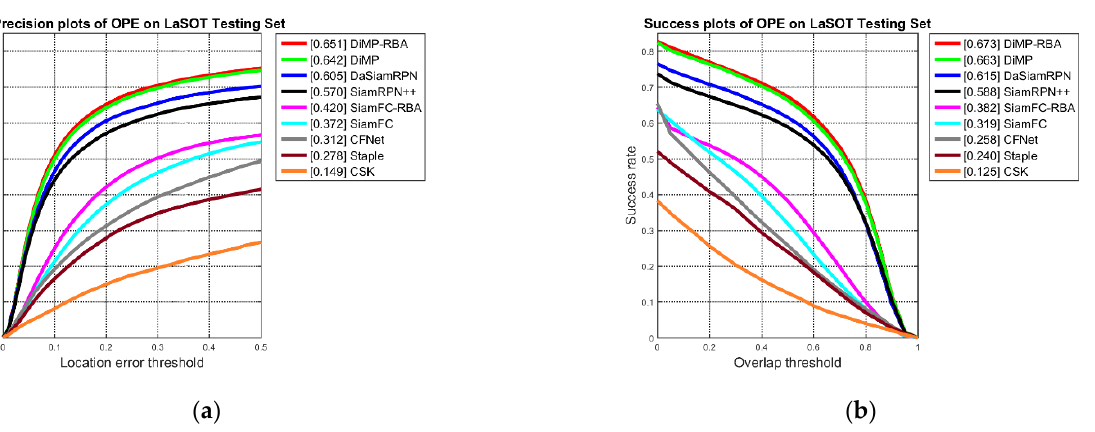
Figure 11. Comparison between the proposed method and baseline trackers on the LaSOT benchmark: ( a ) precision plots; ( b ) success plots.